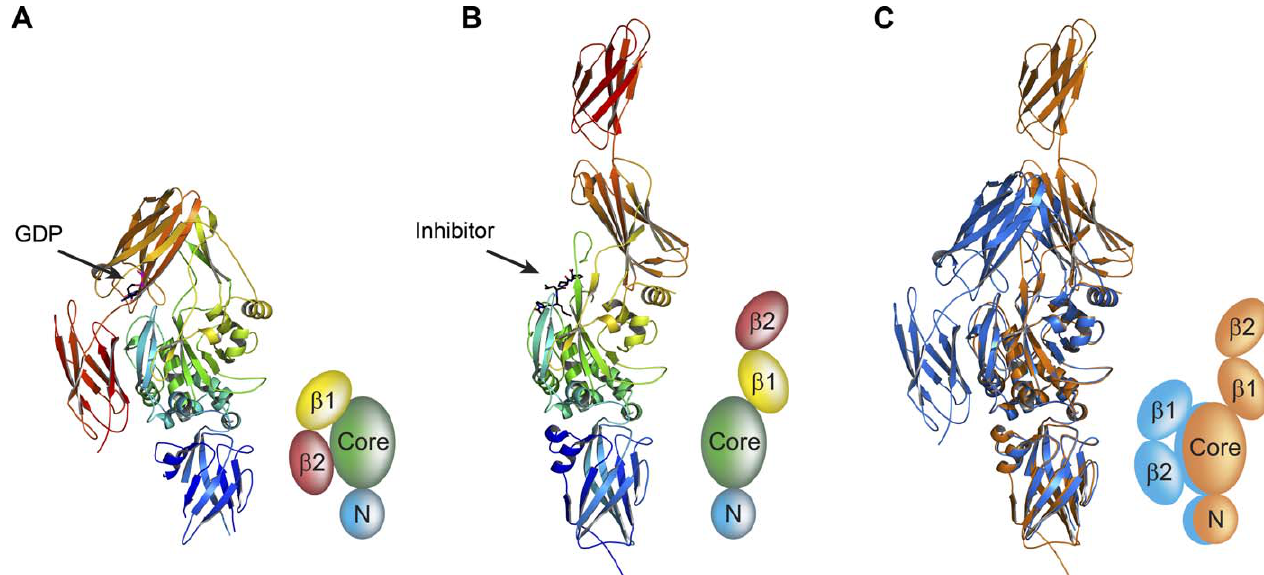
Figure 3. Overall Structures of GDP-Bound and Inhibitor-Bound TG2 The crystal structures are shown as ribbons, and simplified cartoons are included for clarity. (A and B) The N-terminal b -sandwich is shown in blue (N), the catalytic domain (Core) in green, and the C-terminal b -barrels ( b 1 and b 2) in yellow and red, respectively. (A) GDP-bound TG2 [16]. (B) TG2 inhibited with the active-site inhibitor Ac-P(DON)LPF-NH 2 . (C) The N-terminal b -sandwich and catalytic domains of the two structures are superimposed, highlighting the conformational change. The GDP-bound structure is shown in blue and the inhibitor-bound structure in gold. doi:10.1371/journal.pbio.0050327.g003 PLoS Biology |